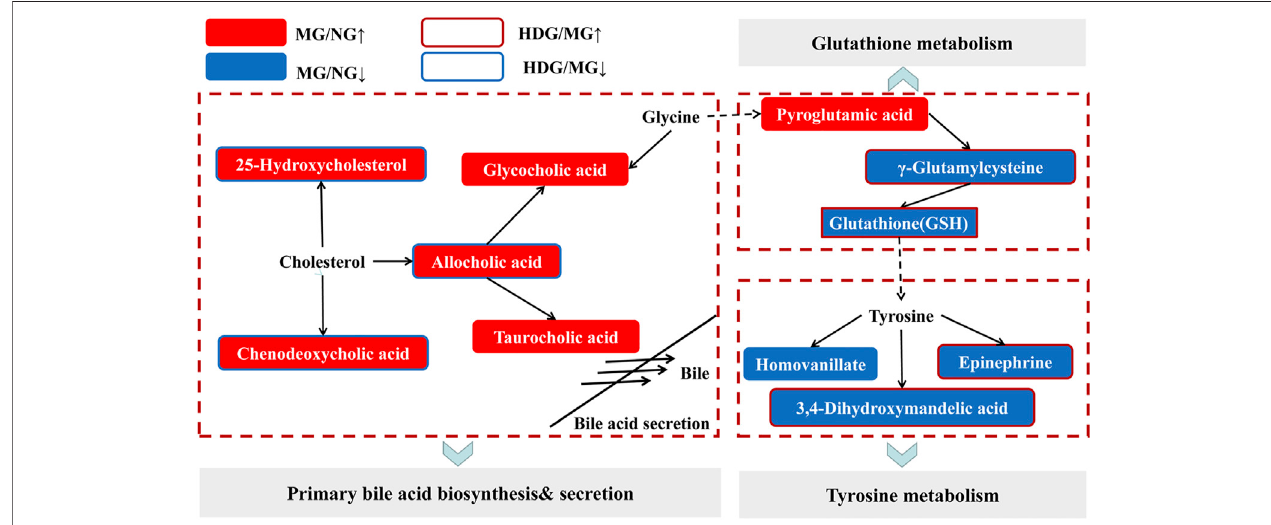
FIGURE 9 | Sketch map of the metabolic pathway correlated with CHI and HGJD therapy. The red and blue solid boxes represent that metabolites were signi fi cantly elevated or reduced in the model group when contrasted with normal group, respectively. The boxes with red and blue border indicated that metabolites were signi fi cantly increased or decreased in the HGJD group when compared with model group, respectively.